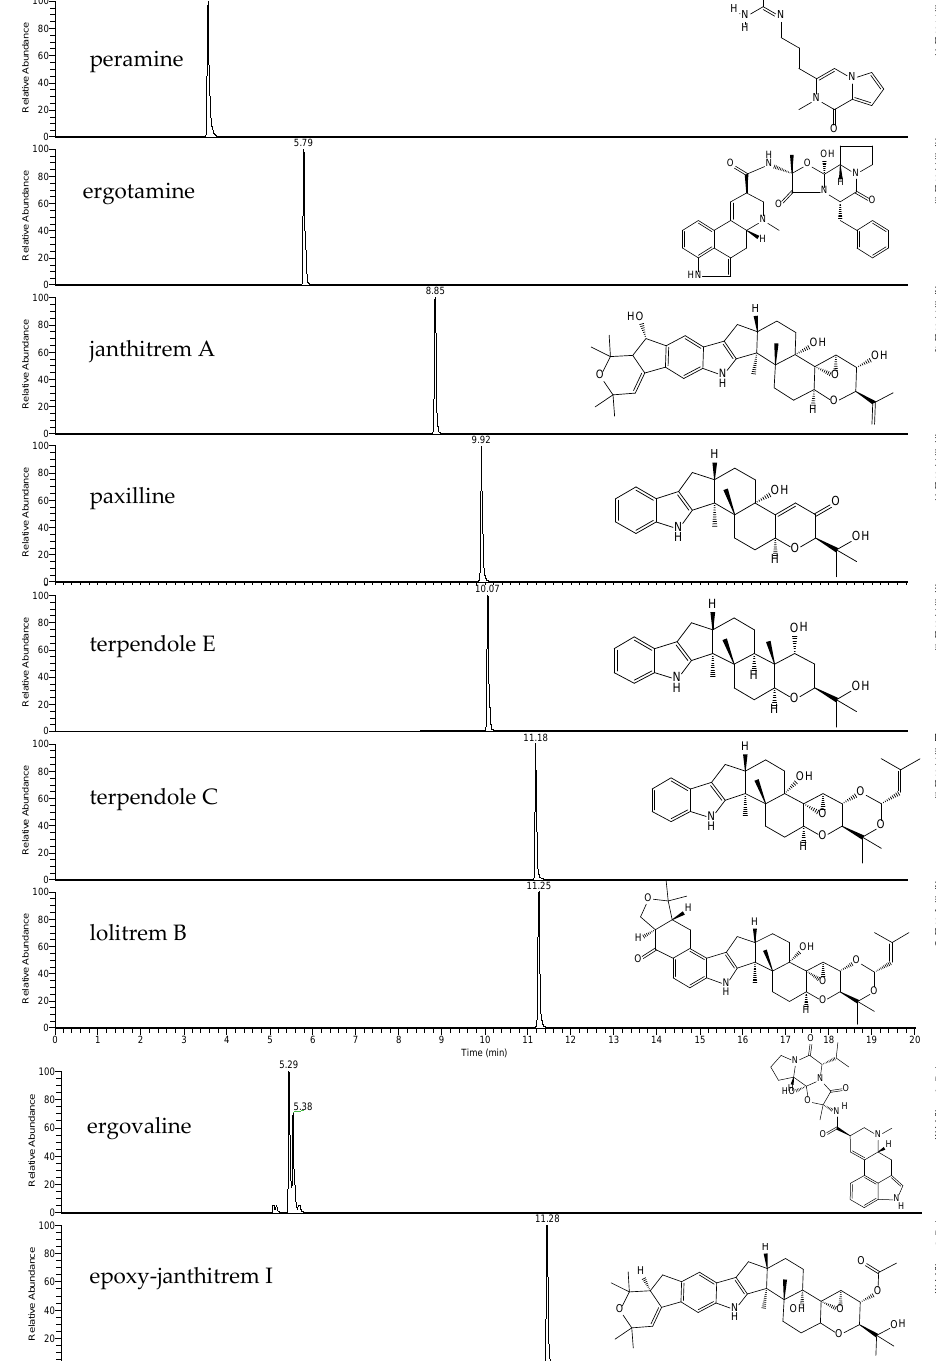
Figure 1. Extracted ion chromatograms (EICs) and chemical structures of the alkaloid standards peramine, ergotamine, janthitrem A, paxilline, terpendole E, terpendole C, lolitrem B, ergovaline and epoxy-janthitrem I. Endogenous ergovaline was extracted from perennial ryegrass Alto-SE seeds, whilst endogenous epoxy-janthitrem I was extracted from Alto-NEA12